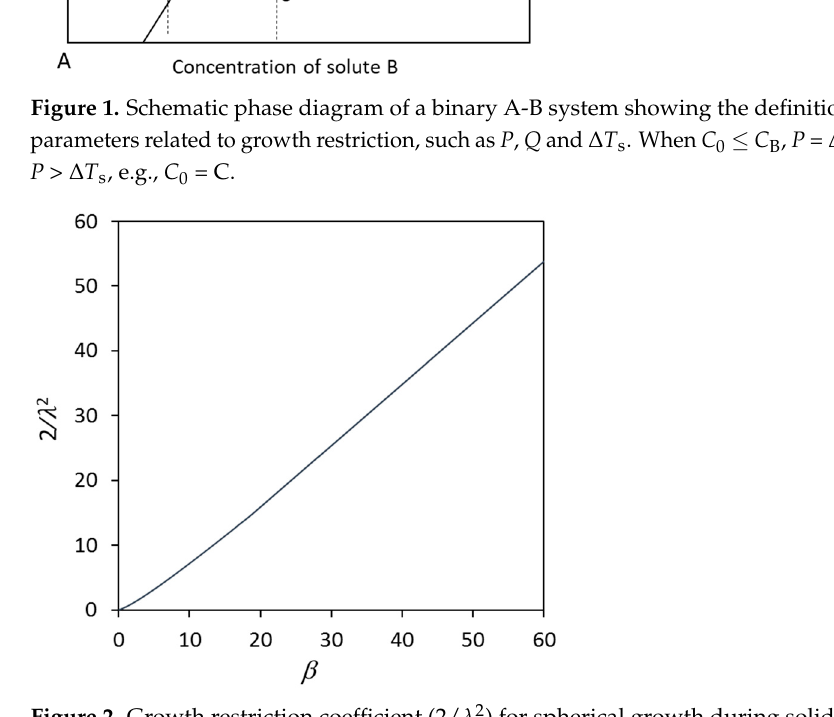
Figure 2. Growth restriction coefficient (2/ λ 2 ) for spherical growth during solidification of binary alloys as a function of the growth restriction parameter, β , showing that the growth restriction coefficient is a unique function of β , regardless of the nature of solutes, solute concentrations and solidification conditions. Reprinted with permission from Ref. [80]. Copyright 2022